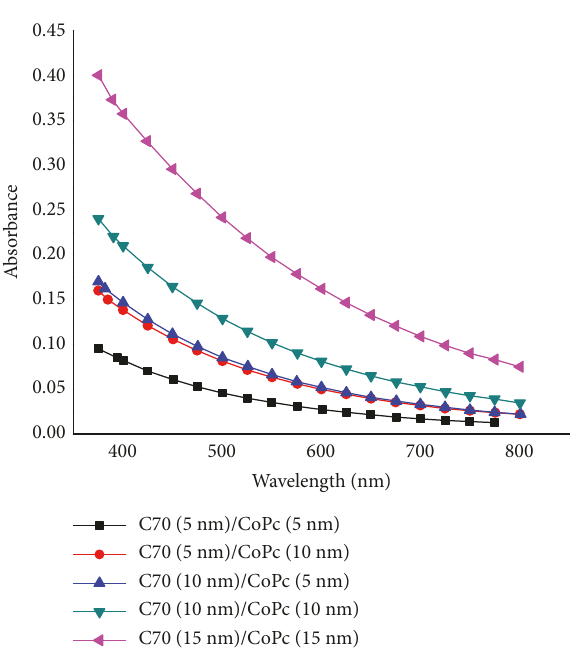
Figure 5: Absorbance plot of CGL at various